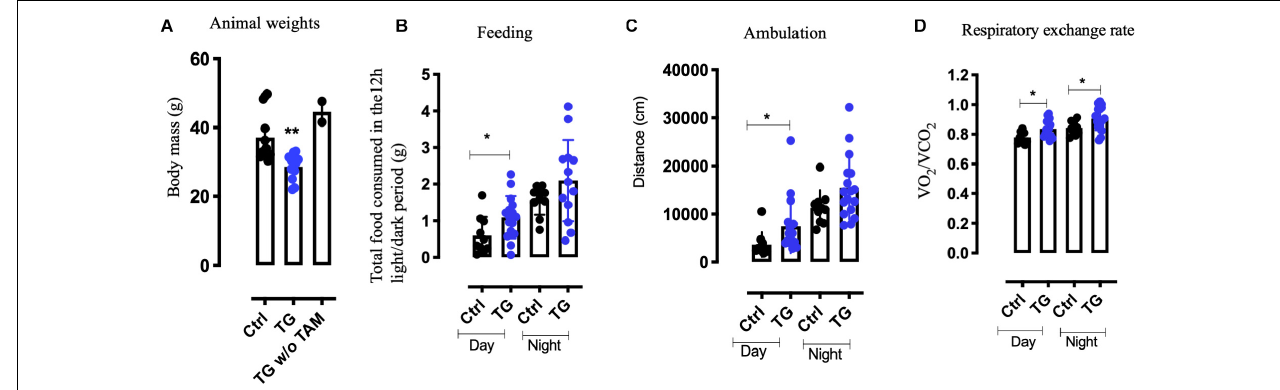
FIGURE 2 | Increased metabolism and a lean phenotype is observed in the transgenic animals. (A) Weights of tamoxifen injected (TG) N = 10, tamoxifen uninjected (TG w/o TAm) N = 4 and control animals (Ctrl) N = 10, at 11 months of age. (B) D Metabolic readings using CLAMS suggest increase in food intake (B) and increased activity (C) in the TG mice. (D) The respiratory exchange rate was higher both during day and night in the TG mice ( N = 12). One-way ANOVA, Student’s t -test, * p -value < 0.01, ** p -value < 0.001, error bars represent Means ± SEM. CLAMS- comprehensive lab animal monitoring systems.